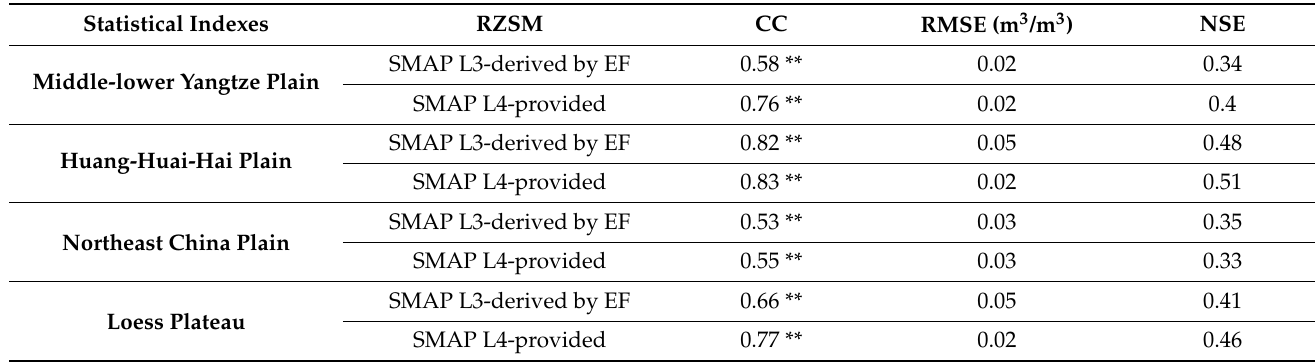
Table 3. Performance metrics of SMAP L3-derived and L4-provided RZSMs against the in-situ ground observations in five different agricultural zoning areas. (Herein, all statistical metrics were calculated after bias correction, and ** indicates significant correlation at p <